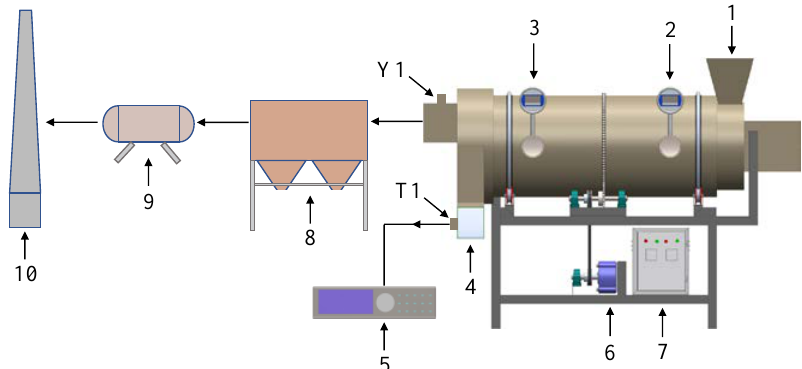
Figure 2. Schematic diagram of pre-drying experimental system: (1) inlet soil, (2) flue gas inlet and gas temperature indicator, (3) flue gas outlet and gas temperature indicator, (4) soil export, (5) data acquisition instrument, (6) electric machinery, (7) electric cabinet, (8) bag filter, (9) condenser and (10) chimney, T1/Y1: sampling hole.